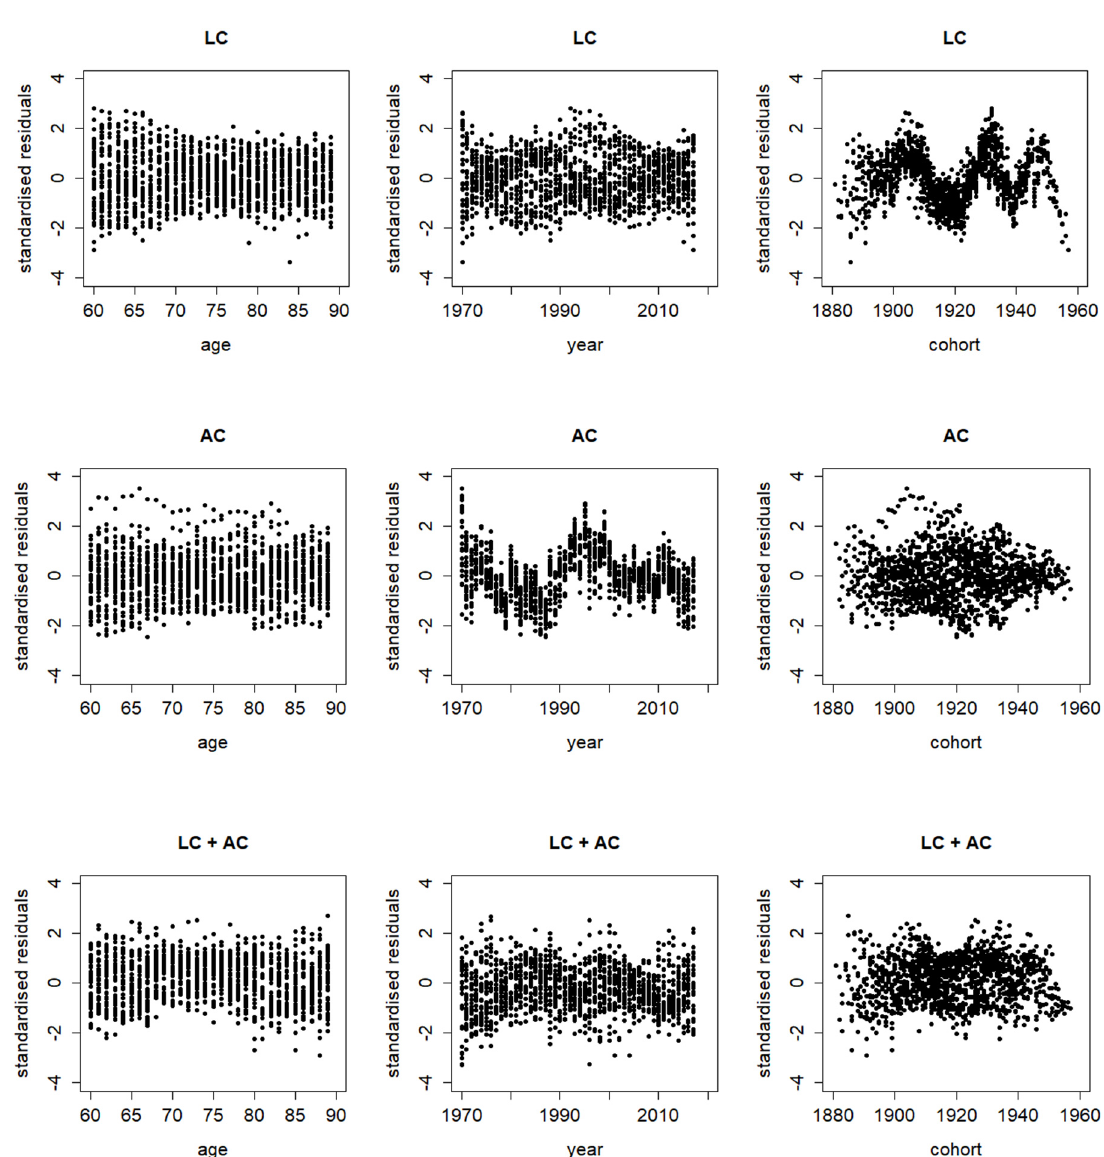
Figure 6. Standardised residuals by age, calendar year, and cohort year from Bayesian Lee–Carter model (alone), age-cohort model (alone), and mixture model.